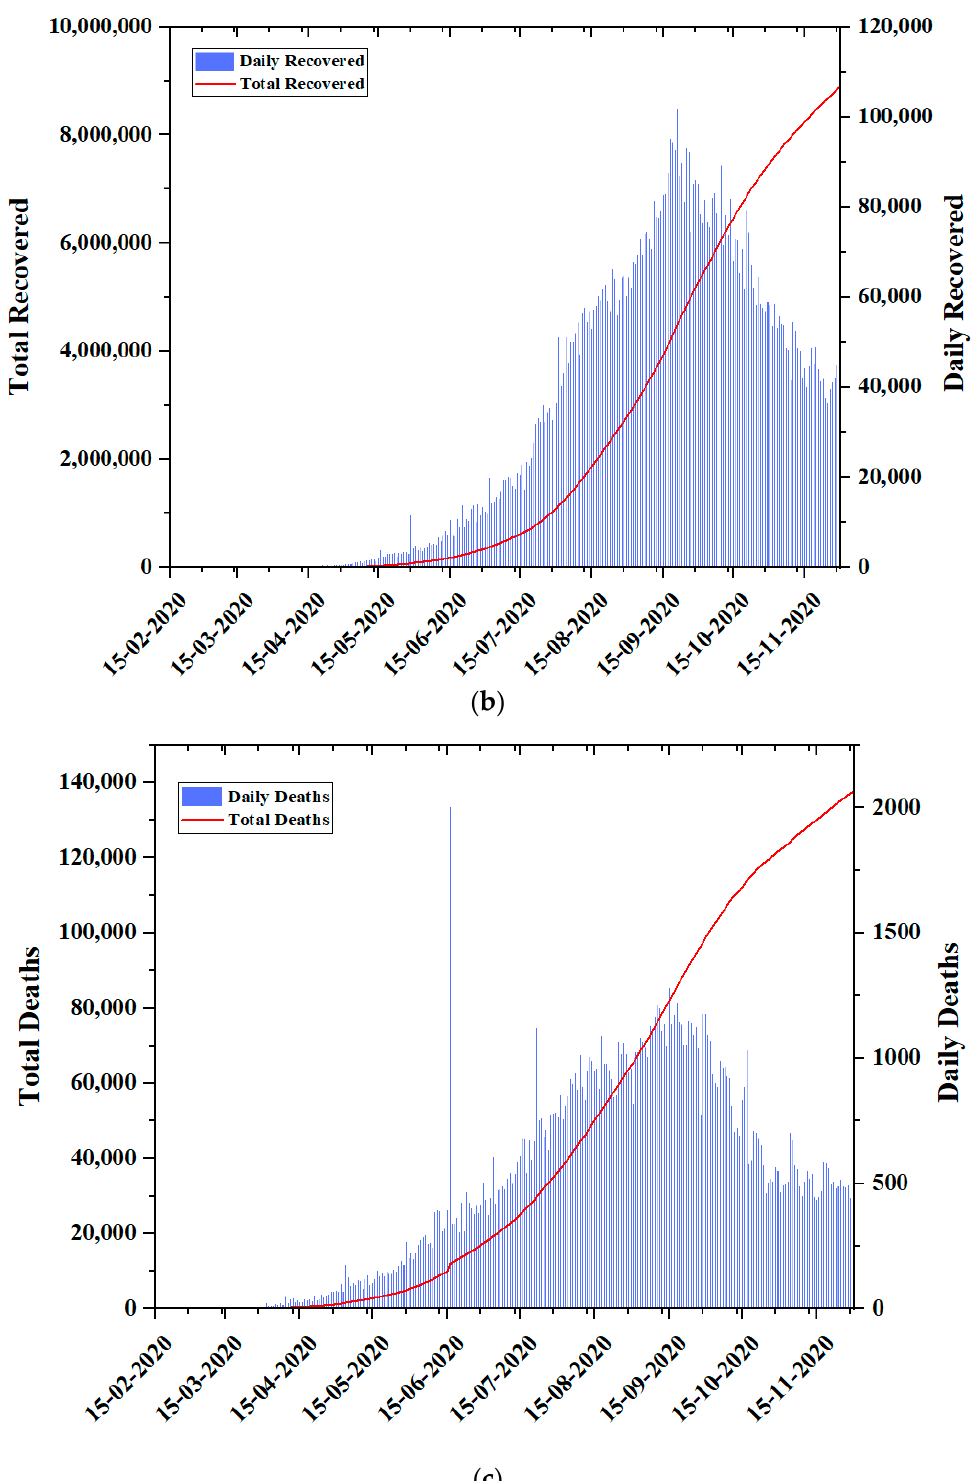
Figure 3. The variations in cumulative and daily cases with number of cumulative cases and new daily cases are represented on left side and right side respectively for ( a ) Infected ( b ) Recovered ( c ) Deaths.